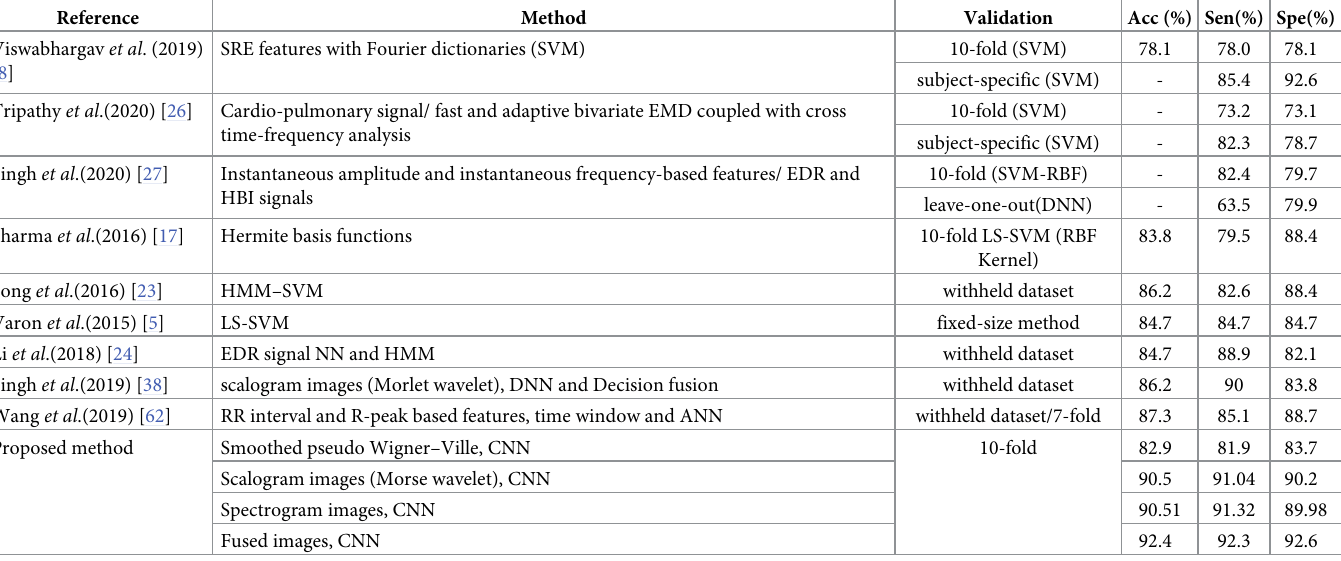
Table 2. Performance comparison of proposed and previous methods for per-segment apnea